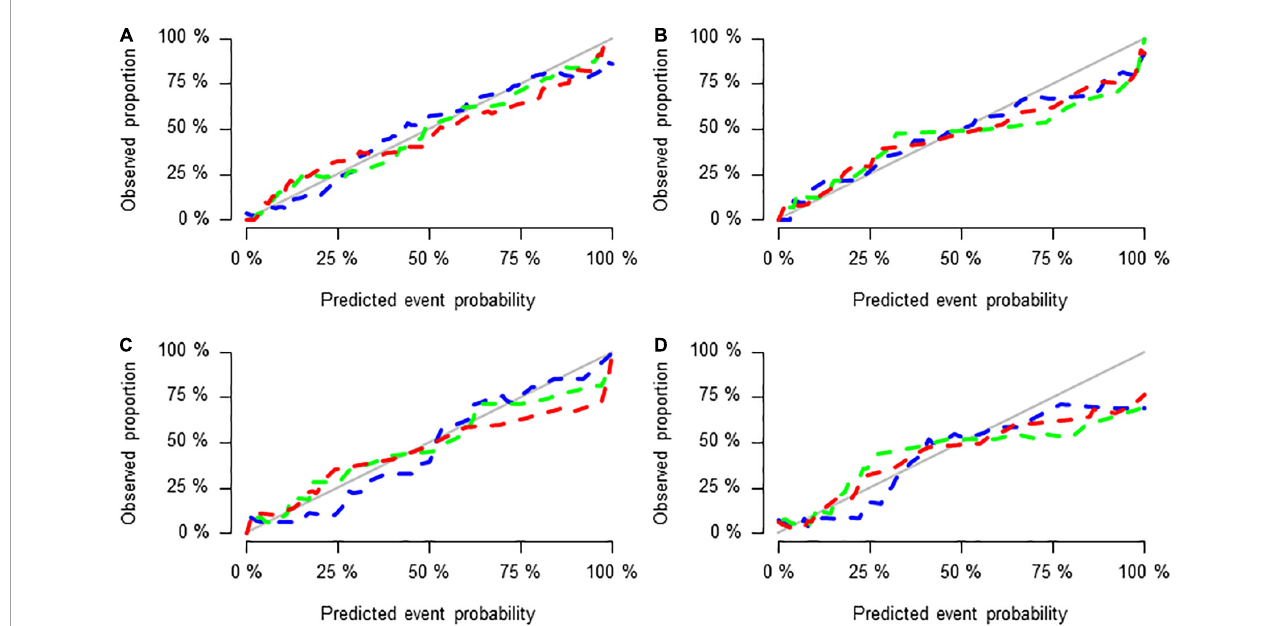
FIGURE5 Calibration curves of the three groups of models in the training set (A) , test set (B) , validation set 1 (C) , and validation set 2 (D) .